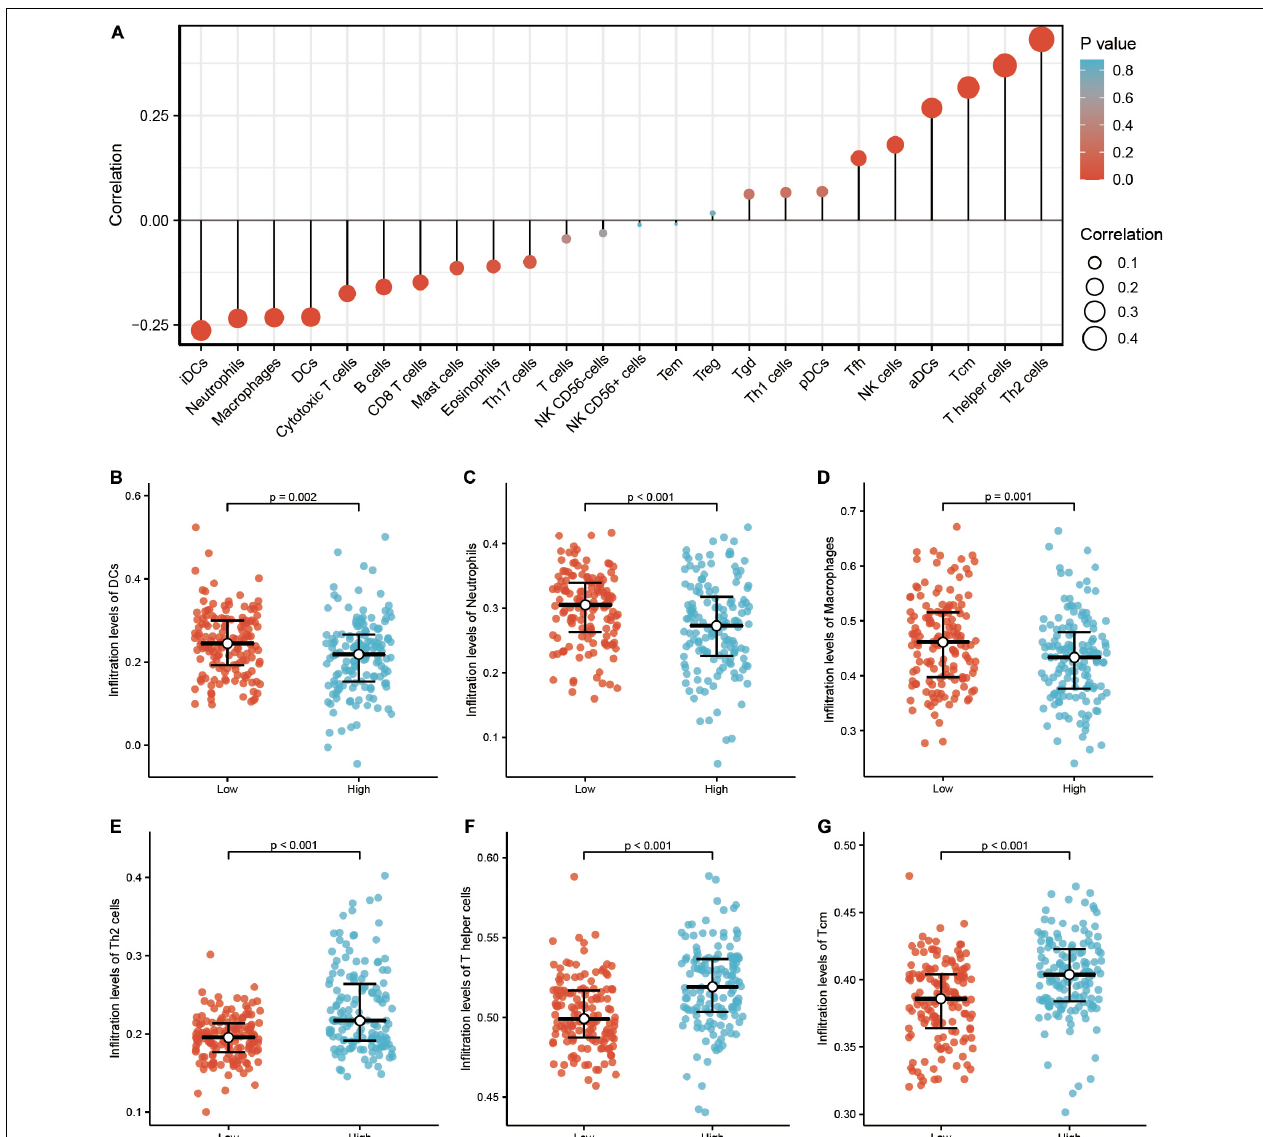
FIGURE 3 | Correlation of immune cell infiltration and TICRR expression in papillary renal cell carcinoma (PRCC) patients. (A) Relationships among infiltration levels of 24 immune cell types and TICRR expression profiles by Spearman’s analysis. Shown is the comparison of infiltration levels of most correlated immune cells, including dendritic cells (B) , neutrophils (C) , macrophages (D) , type 2 T helper cells (Th2) cells (E) , Th cells (F) , and Tcm memory cells (G) between high- and low- TICRR expression groups. DCs, dendritic cells; aDCs, activated DCs; iDCs, immature DCs; pDCs, plasmacytoid DCs; Th, T helper cells; Th1, type 1 Th cells; Th2, type 2 Th cells; Th17, type 17 Th cells; Treg, regulatory T cells; Tgd, T gamma delta; Tcm, T central memory; Tem, T effector memory; Tfh, T follicular helper; NK, natural